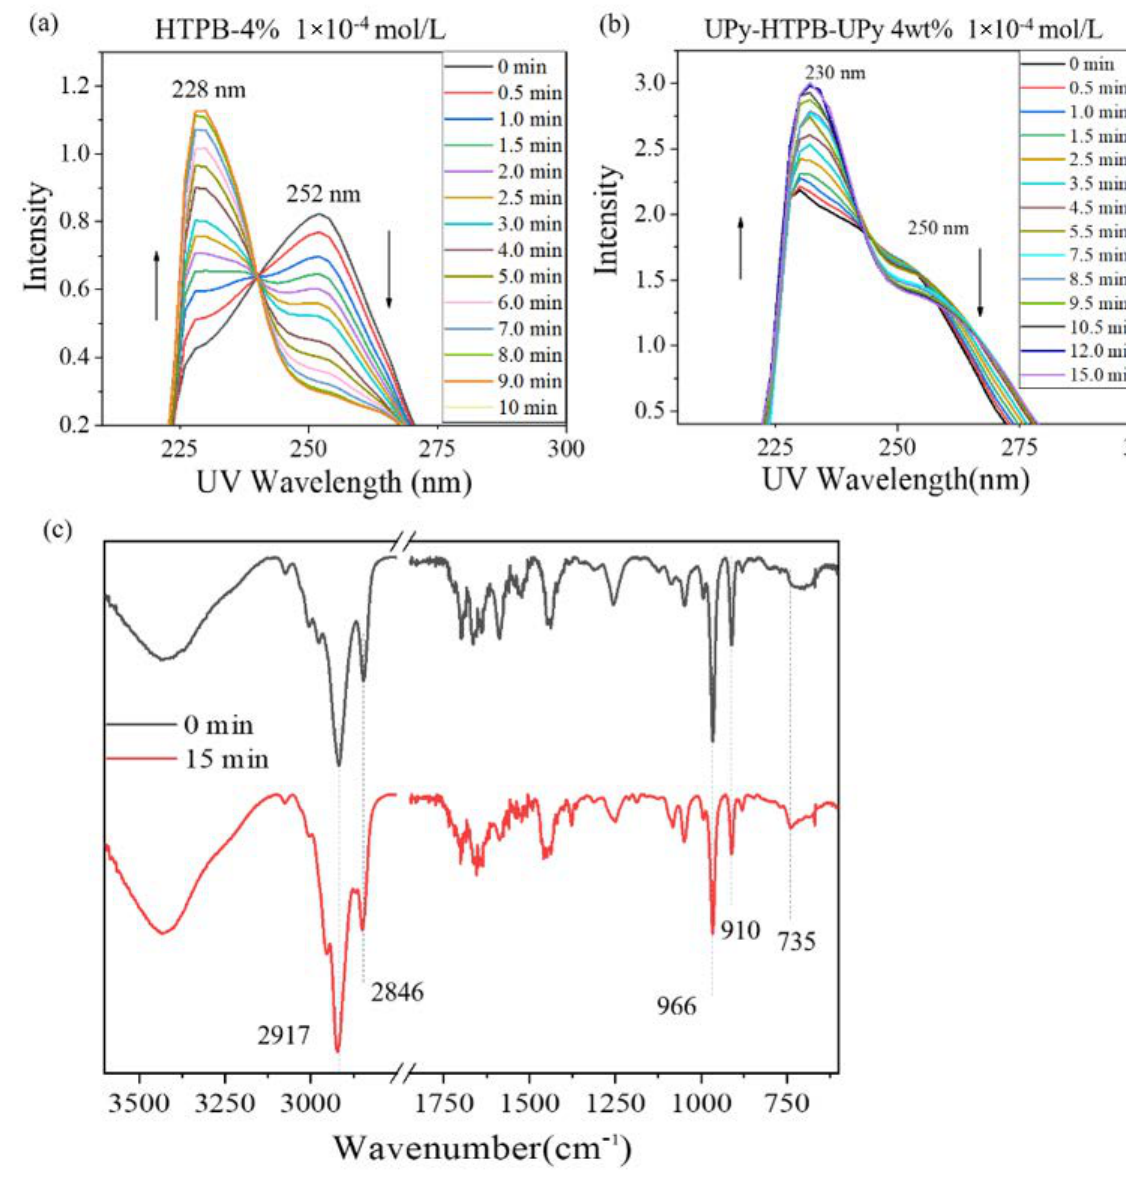
Figure 3. Ultraviolet spectra of ( a ) HTPB-4% and ( b ) UPy-HTPB-UPy-4% with different irradiation times under 365 nm UV; and ( c ) FTIR spectra of UPy-HTPB-UPy-4% before and after UV cross-linking (right: zoomed-in